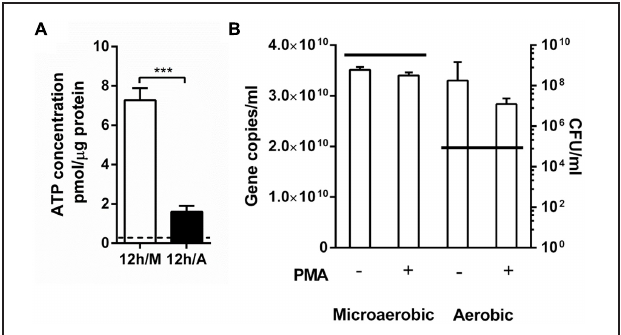
FIGURE 5 | Comparison of intracellular ATP levels and viability in C. jejuni between aerobic and microaerobic conditions. (A) The concentrations of intracellular ATP in C. jejuni after 12 h culture under microaerobic conditions (12 h/M) and aerobic conditions (12 h/A). The initial ATP level at 0 h is indicated with a dotted line. A Student’s t -test was carried out for statistical analysis. ∗∗∗ P < 0.001. (B) Quantitative PCR (qPCR) was performed with or without PMA treatment after 12 h growth under different oxygen conditions. A horizontal line indicates the average CFU levels of the samples that were used for